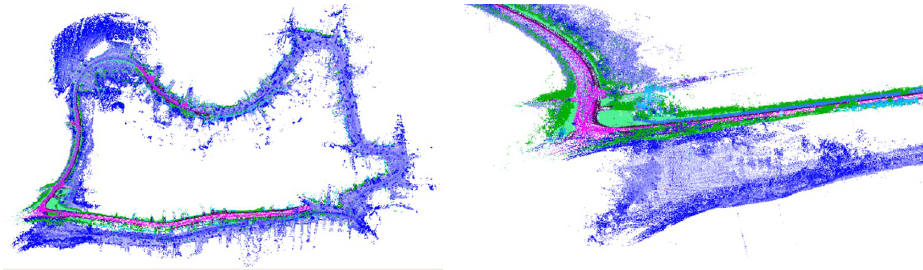
Fig 11. Vertical global consistency